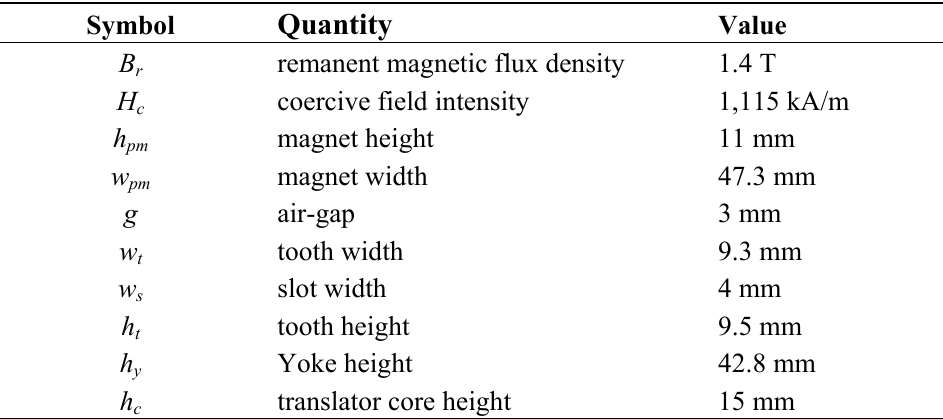
Table 1. Parameters of the generator.